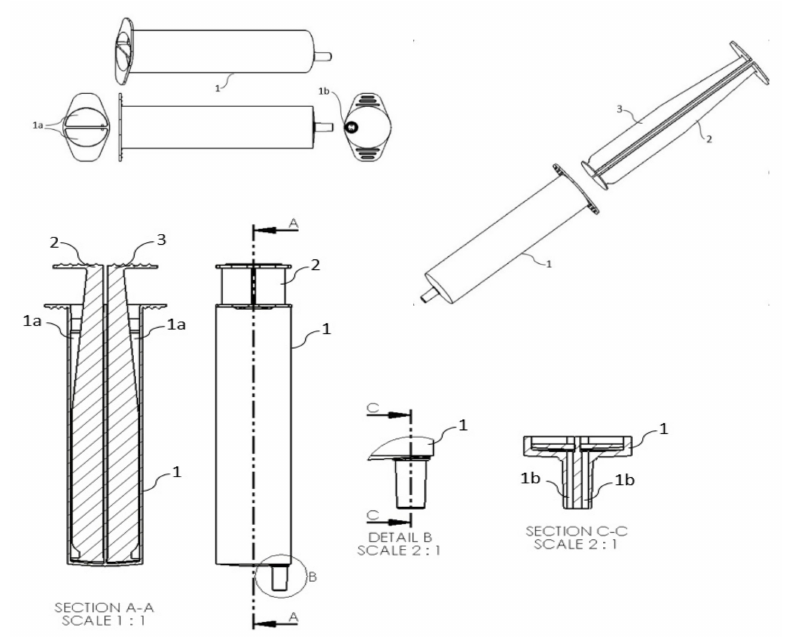
Figure 1. Double-chamber syringe (patent submission number 20192000899107 to Portuguese Authority in Industrial Property; international patent application number PCT / IB2020 / 056219 under the Patent Cooperation